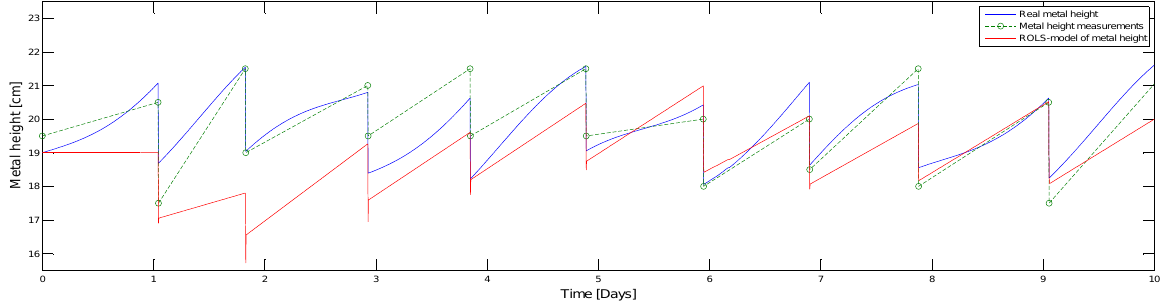
Figure 7: Simulating the predicted metal height using ROLS. Prediction of metal height for the earlier pre- sented synthetic data set showing good correlation between the simulated and predicted values. The prediction model is based on the ROLS algorithm and the noisy metal height measurements shown with the green circles in the figure. Although the initial value is set to high, the predicted values ”‘soon”’ reaches the desirable level. ROLS needs some time to adjust its model parameters and hence the variations in its initial